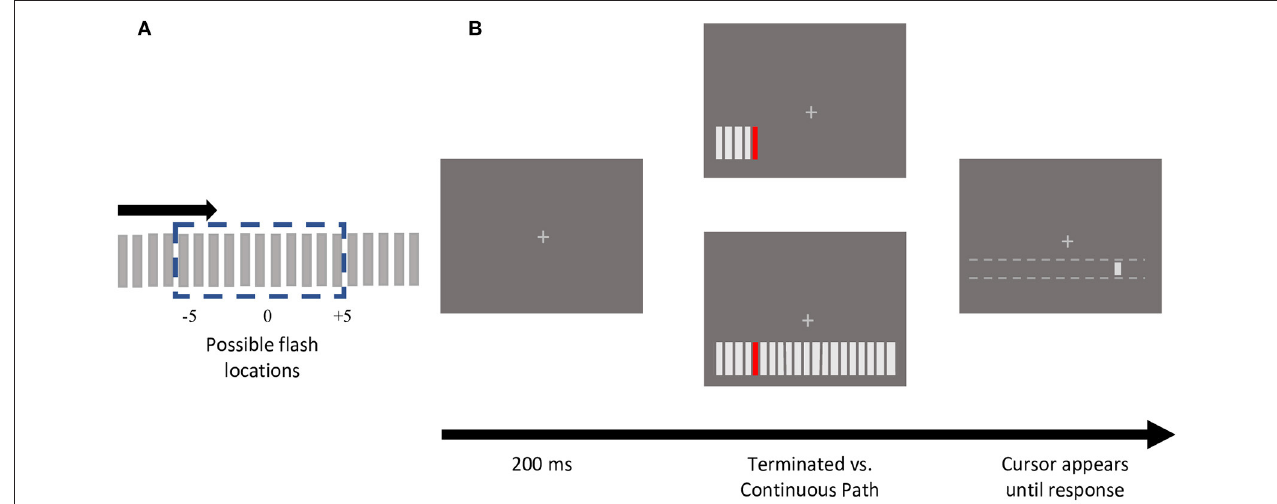
FIGURE 1 | Stimulus schematic and sample trial presentation. (A) An apparent motion sequence comprised of 20 gray, rectangular bars, moved either in a leftward (not depicted) or rightward direction. One of the central 11 positions was presented in one of 4 isoluminant colors (red, green, yellow, and blue). (B) Experimental protocol of trials depicting sample terminating vs. continuing motion path trials. For each motion path (terminating or continuing), each of the 11 central bar positions were tested, using both directions, and all 4 colors. Participants reported the colored flash location by clicking with a mouse, that could only move horizontally along the motion path. Note that the dotted white lines did not appear on the